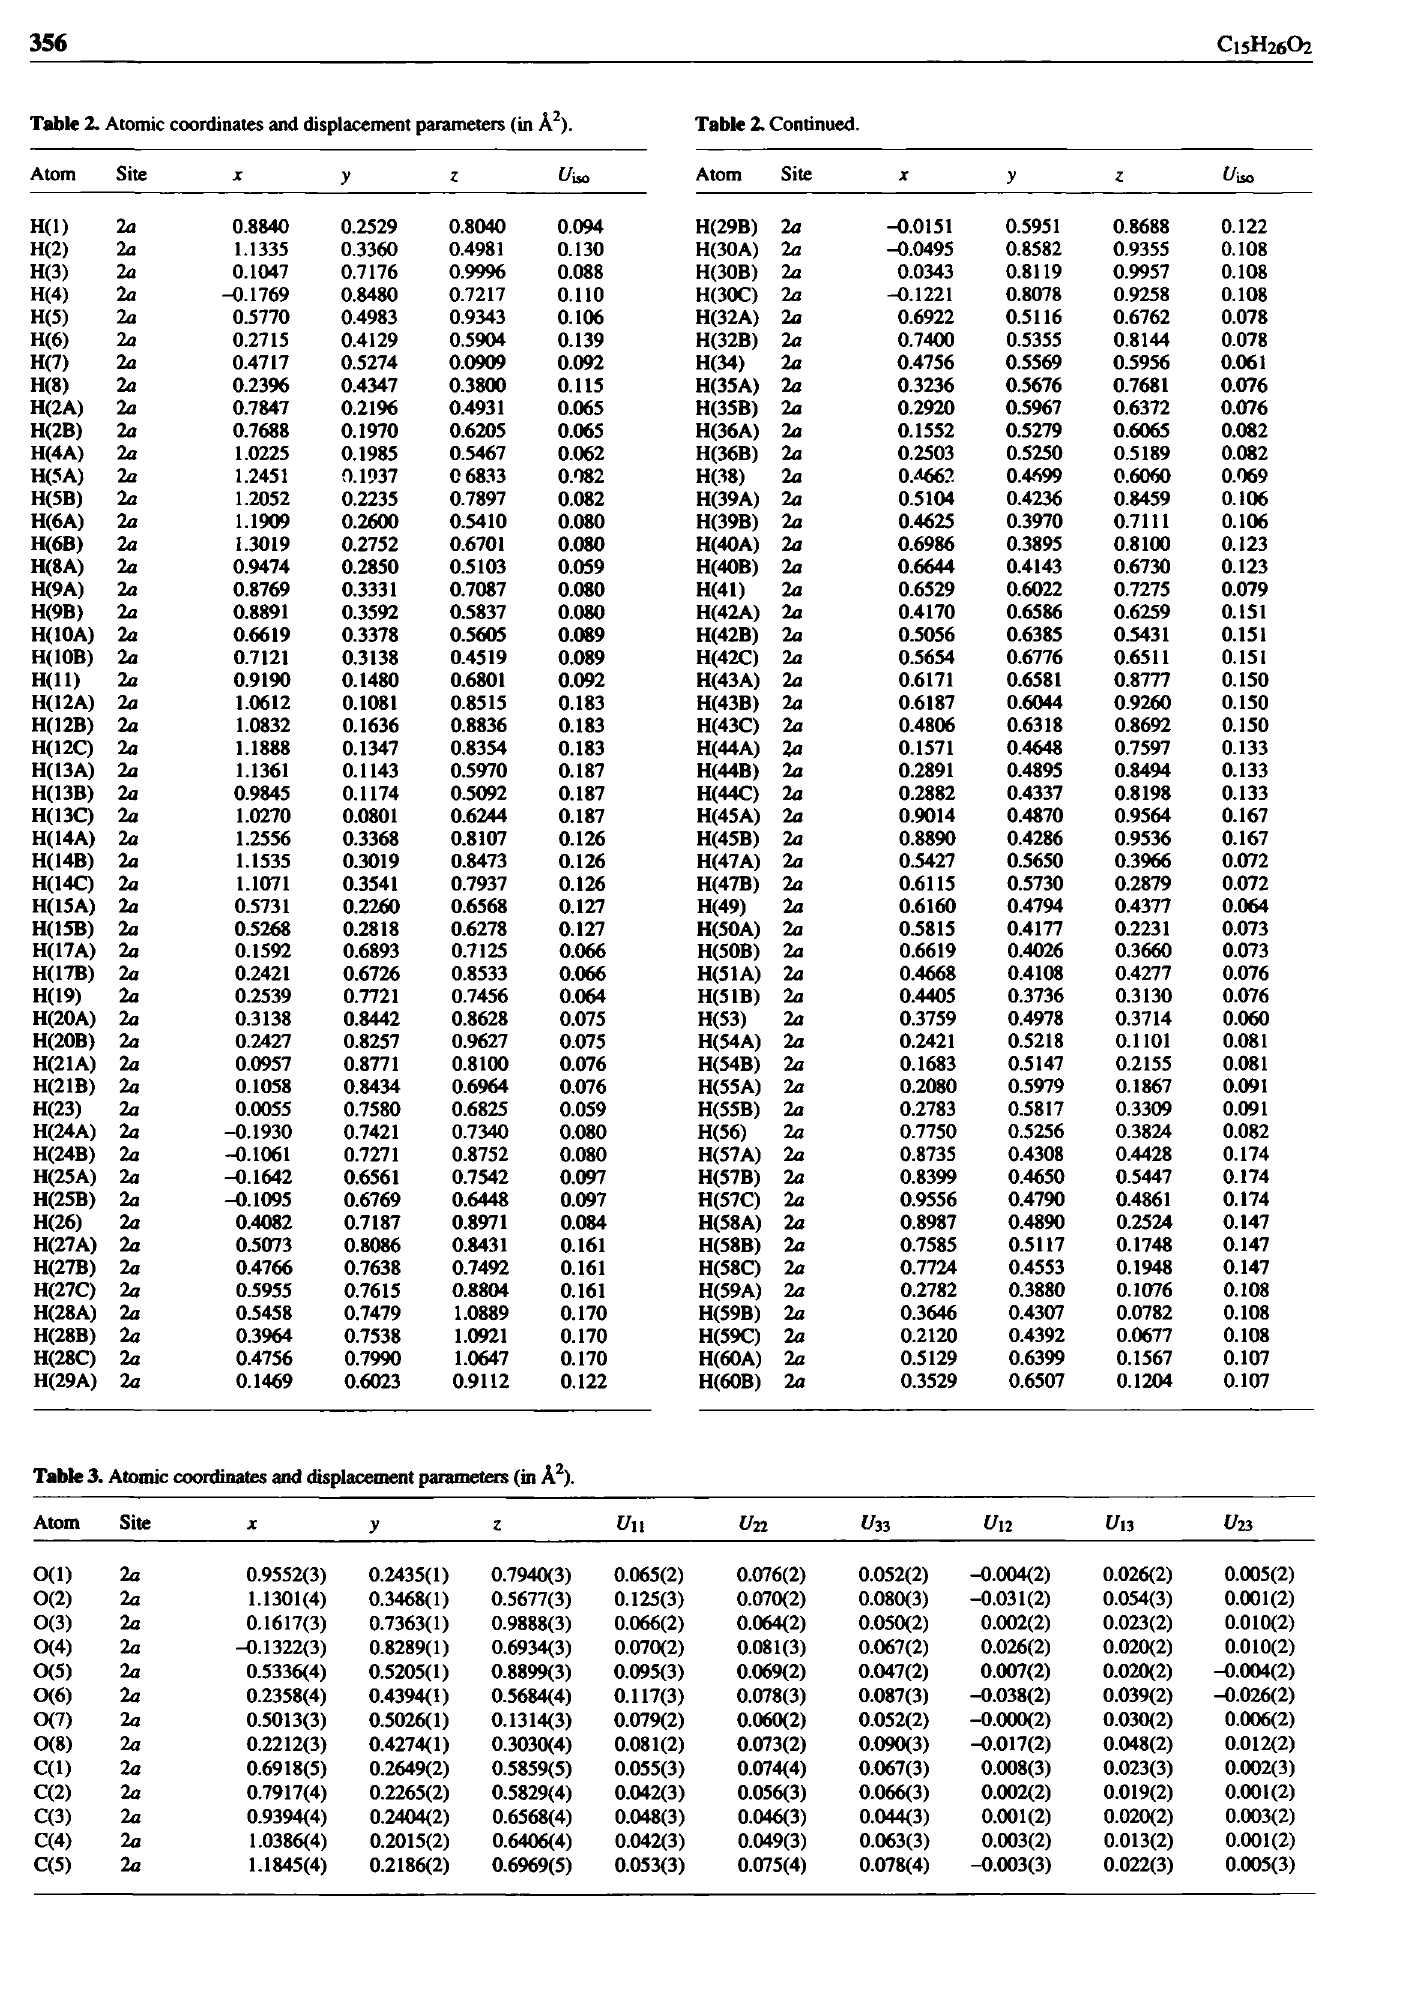
Table 2. Atomic coordinates and displacement parameters (in A 2 ).